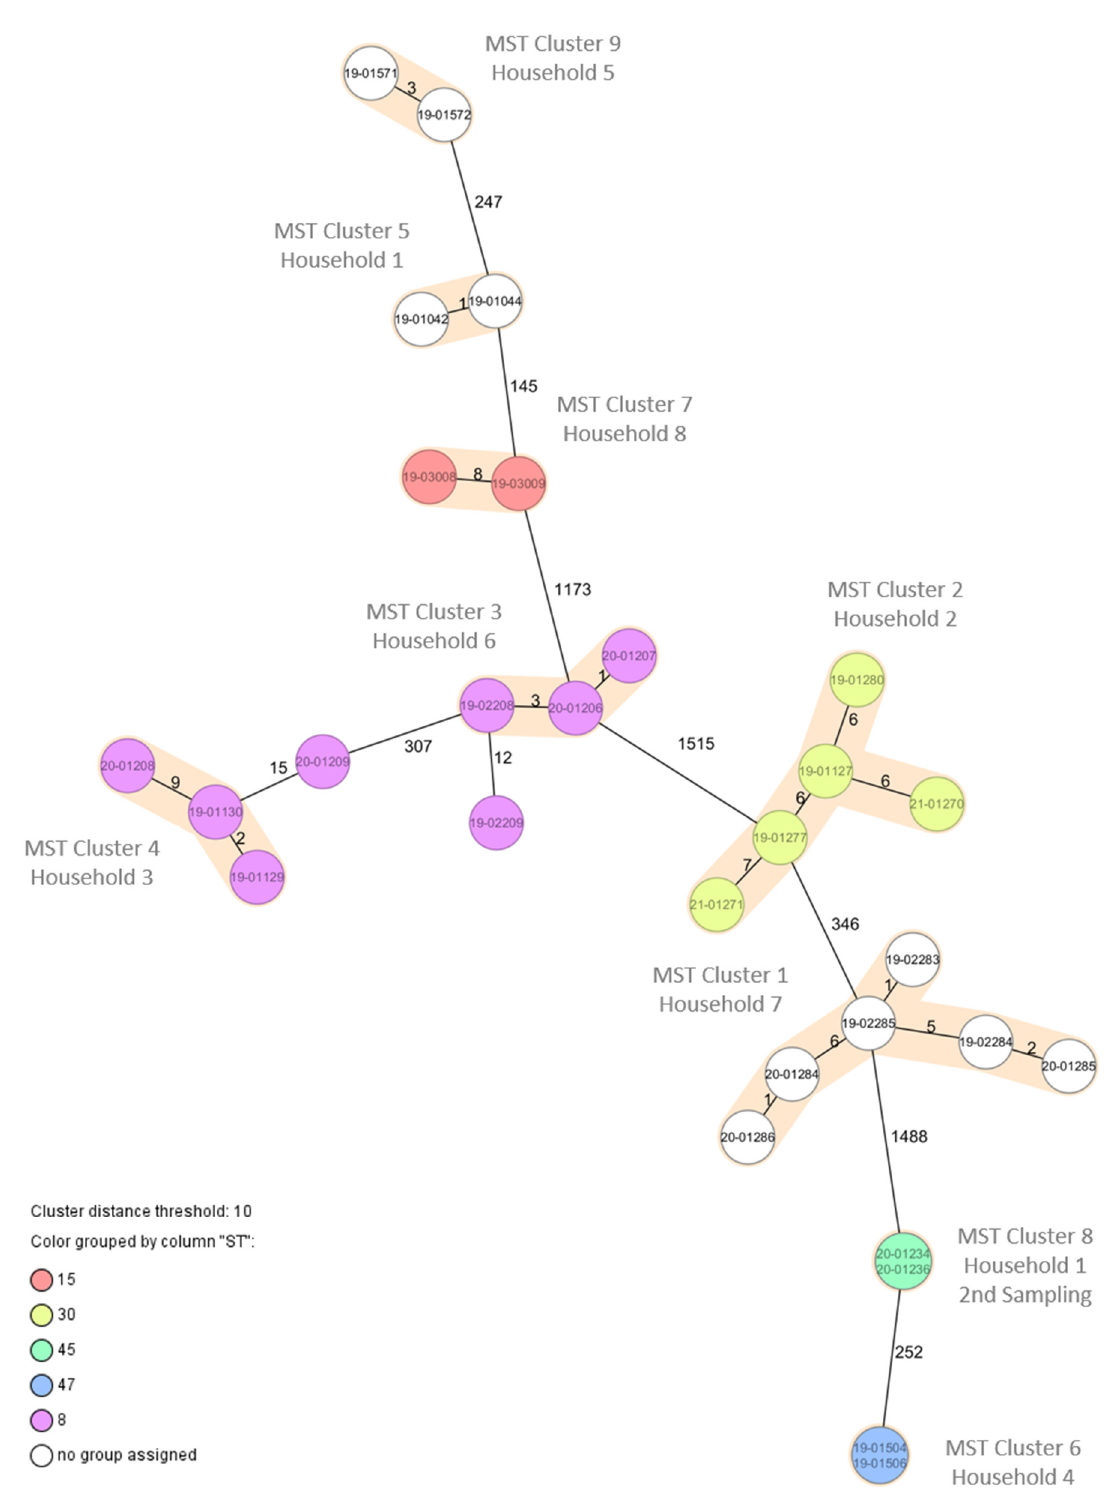
Figure 1. Minimum spanning tree based on core-genome multilocus sequence typing allelic profiles of 27 S. aureus isolates from humans and dogs in eight households. Colors indicate the MLST CC (as deduced from WGS data). Brown shades indicate clusters with <10 allelic differences between the